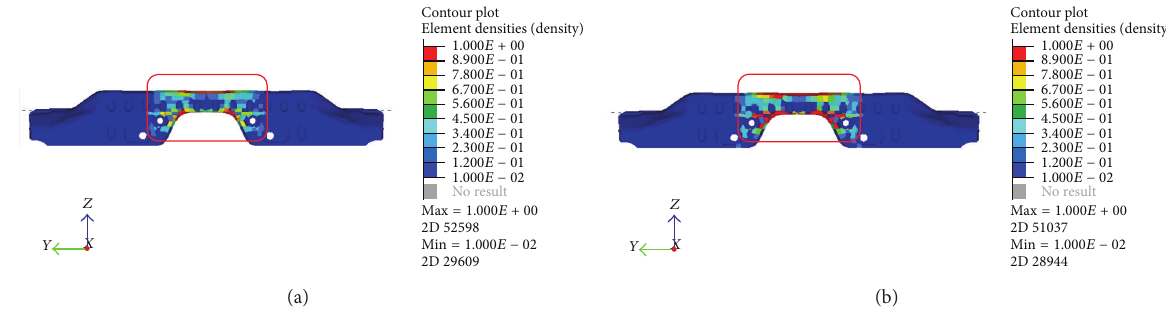
Figure 11: Highlight of reinforcement areas on rear seat center member and rear floor extension 4 mm and 3.2